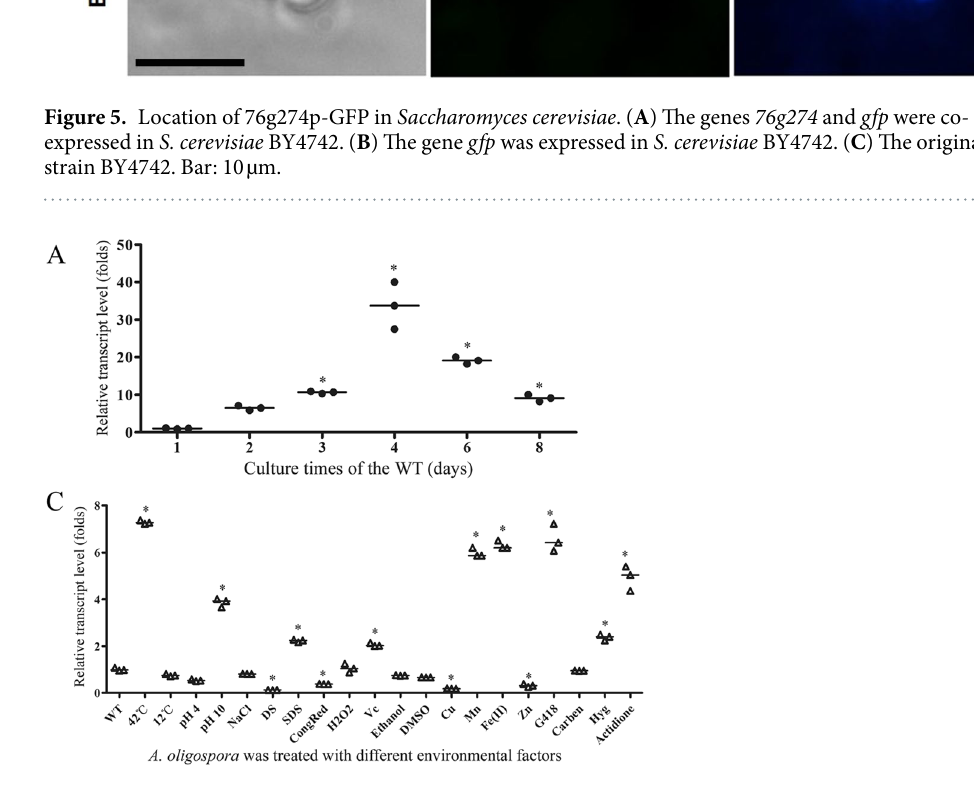
Figure 6. Transcriptional analysis of the gene 76g274 in A. oligospora under different conditions. β -tubulin gene (AOL_s00076g640) of A. oligospora was used as the internal control. ( A ) The transcription of gene 76g274 in A. oligospora during the growth of A. oligospora in TG medium. * P < 0.05 versus 1 st day. ( B ) The transcription of gene 76g274 under various stress-tolerant conditions (TG broth as basic medium). WT, the control without treated; 42 °C and 12 °C, the mycelia were incubated at 42 °C or 12 °C for 1 h; pH 4 and pH 10, the mycelia were cultured in medium of pH 4 or pH 10 for 4 h; NaCl, the mycelia were treated by 0.5 M NaCl for 4 h; DS, sorbitol (0.5 M); SDS, sodium dodecyl sulfate (0.02%); CongRed, congo red (100 µ g/mL); H2O2, H 2 O 2 (5 mM); Vc, vitamin c (1 mg/mL); Ethanol, 2% ethanol; DMSO, dimethylsulfoxide (2%); Cu, CuSO 4 (5 mM); Mn, MnSO 4 (5 mM); Fe(II), FeSO 4 (5 mM); Zn, ZnSO 4 (5 mM); G418, geneticin sulfate (300 µ g/mL); Carben, carbendazim (300 µ g/mL); Hyg, hygromycin B (200 µ g/mL); Actidione, 200 µ g/mL actidione. The mycelia were treated at above condition for 4 h, respectively. * P < 0.05 versus WT. The horizontal bars depict the median, and data are presented as suggested by Weissgerber et al . 58 and Klaus 59